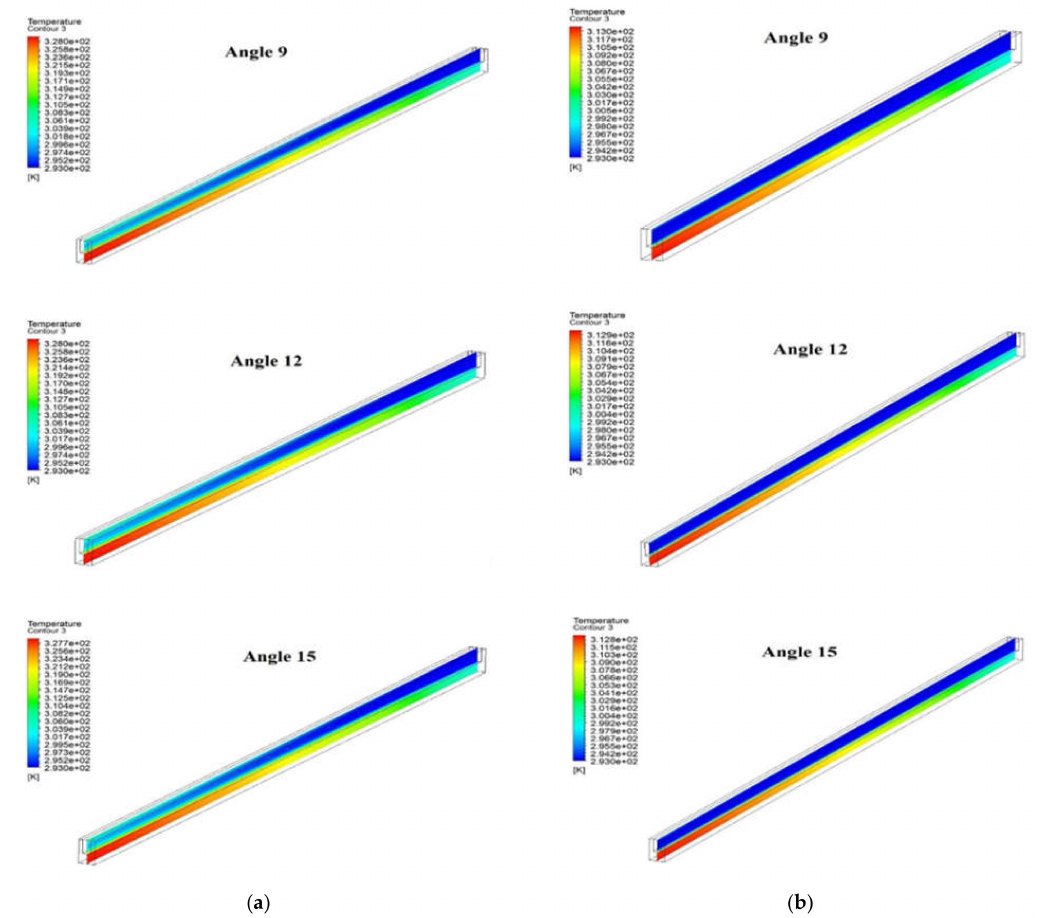
Figure 7. Temperature Contour at mid plane of fluid and microchannel at ( a ) Reynolds Number = 200 and ( b ) Reynolds Number =